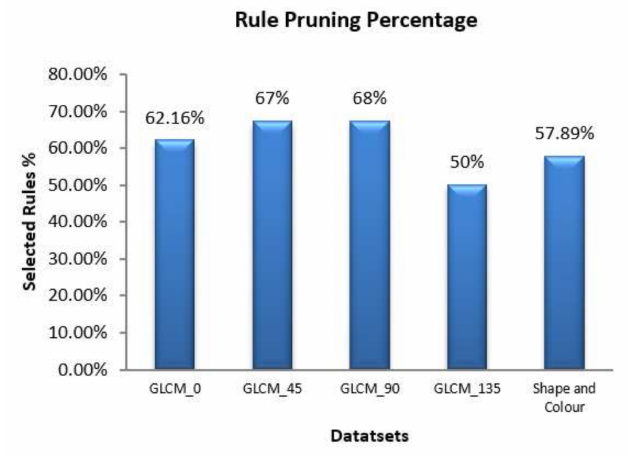
Figure 6. Performance of rule pruning